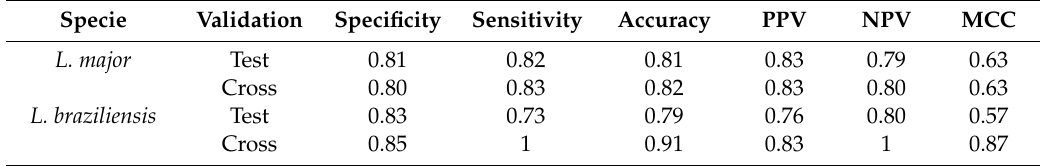
Table 1. Summary of parameters corresponding to the results obtained for all